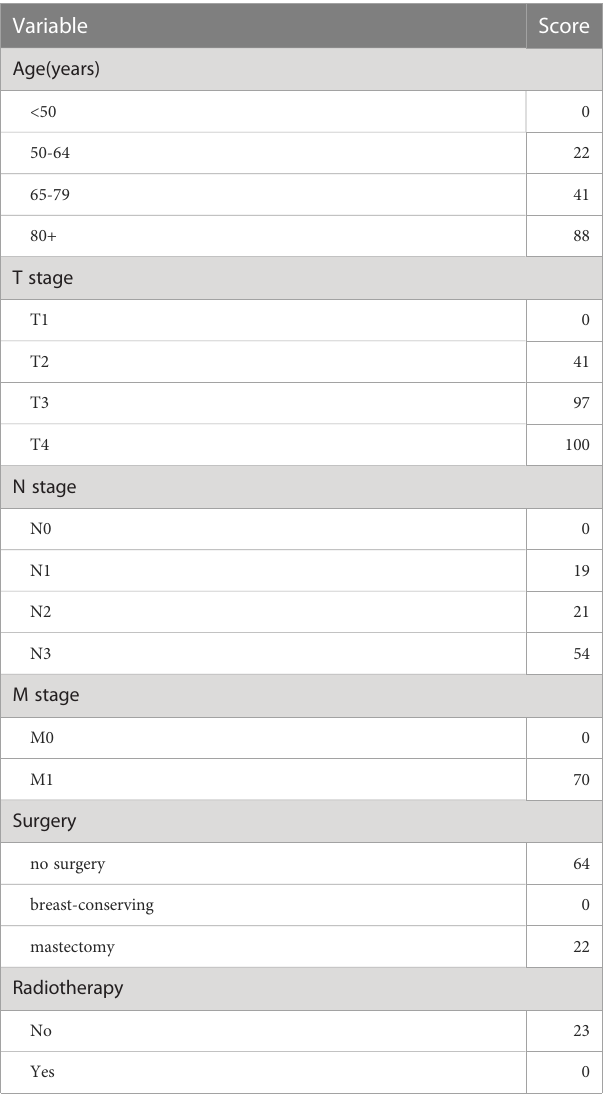
TABLE 3 Point assignment and prognostic score in the nomogram (MBC Training Cohort). Variable